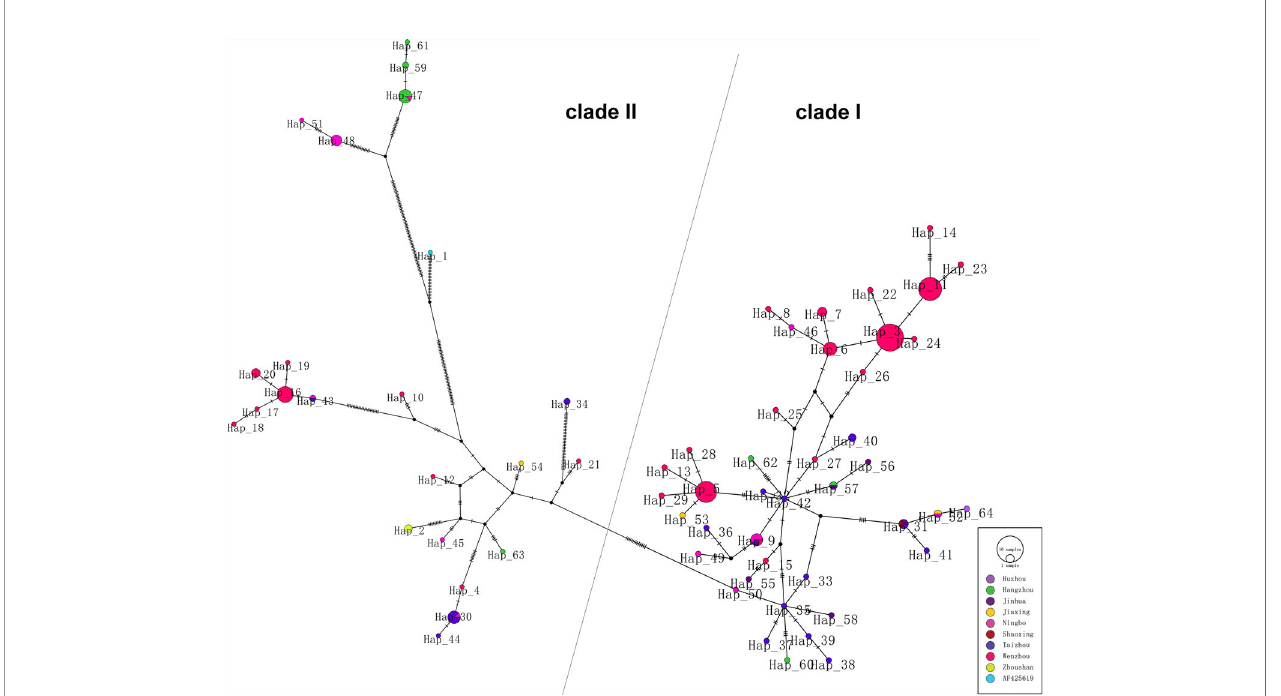
FIGURE 2 | Phylogenetic networks of 174 DENV-1 strains. Each node in the network represents a haplotype, and the circle size of the node represents the number of sequences contained in this haplotype.